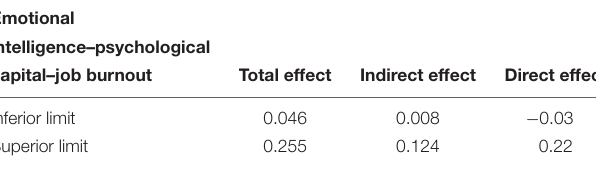
TABLE 9 | Test the mediating effect of psychological capital in the influence of emotional intelligence on job performance.